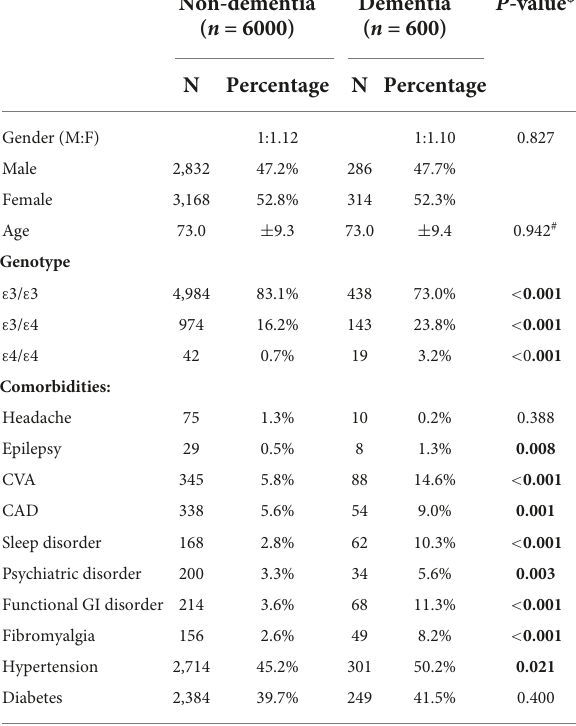
TABLE 1 Demographic characteristics and associated diseases, which occurred 3 months–3 years before the diagnosis of dementia, in dementia, and matched non-dementia